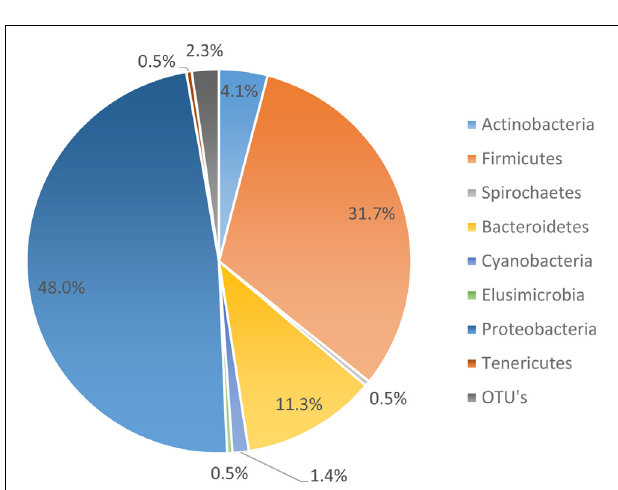
FIGURE 2 | Bio-map of evisceration. The bacterial mean log CFU/mL counts for both Enterobacteriaceae and aerobic plate counts (APC).